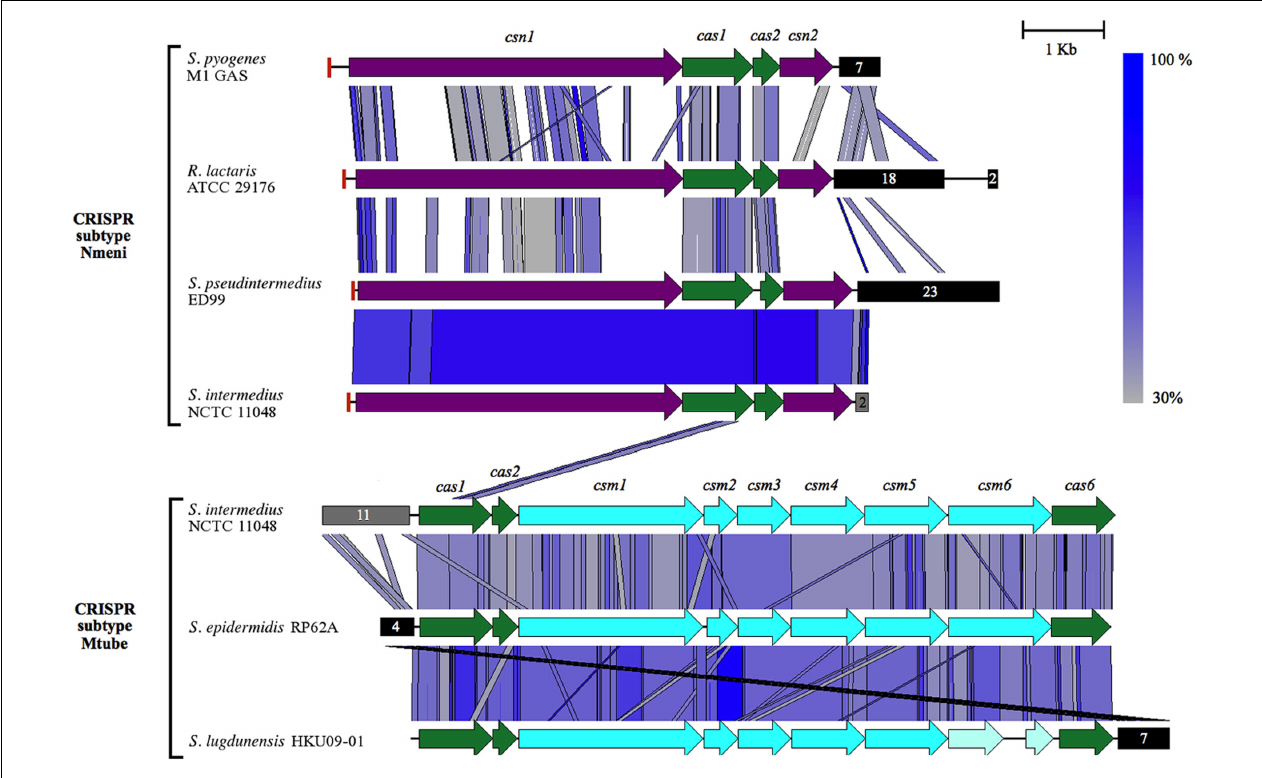
cas family in green, and the csm family in light blue. Of note, the csm6 gene in S. lugdunensis HKU09-01 appears to be a pseudogene. Black boxes represent clusters of direct repeats regions with the number of spacers between the direct repeats indicated.The red box at the beginning of each Nmeni subtype CRISPR locus corresponds to a single copy of the repeats identified in the cluster of downstream direct repeats. The gray boxes indicate the approximate number of direct repeats at the locus in S. intermedius NCTC 11048 (due to the unfinished status of the genome). Figure produced with EasyFig (Sullivan et al.,